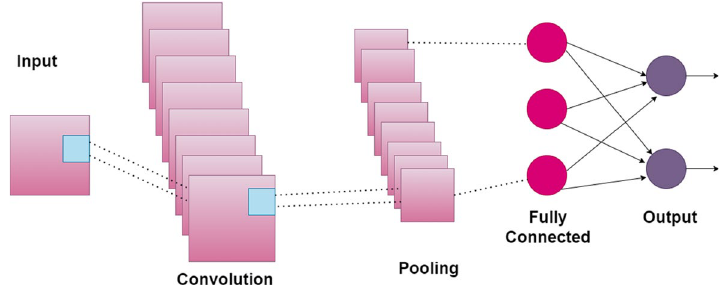
Fig. 3 Convolutional neural